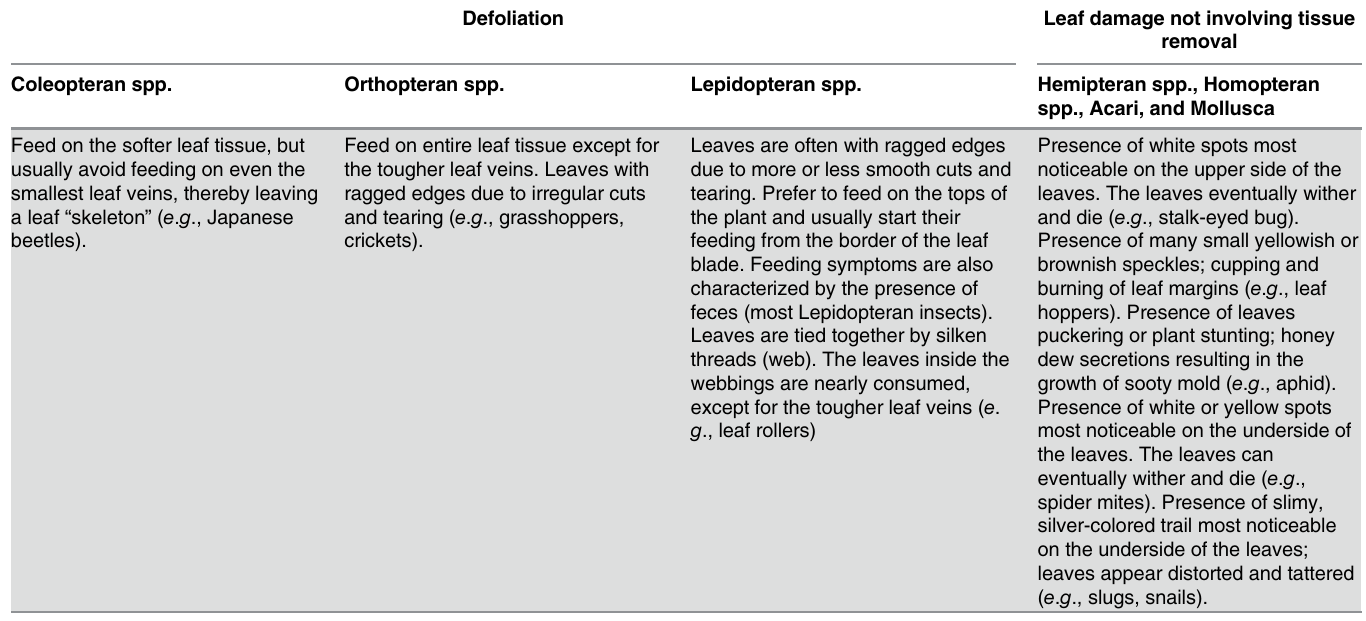
removal spp., Acari, and Mollusca